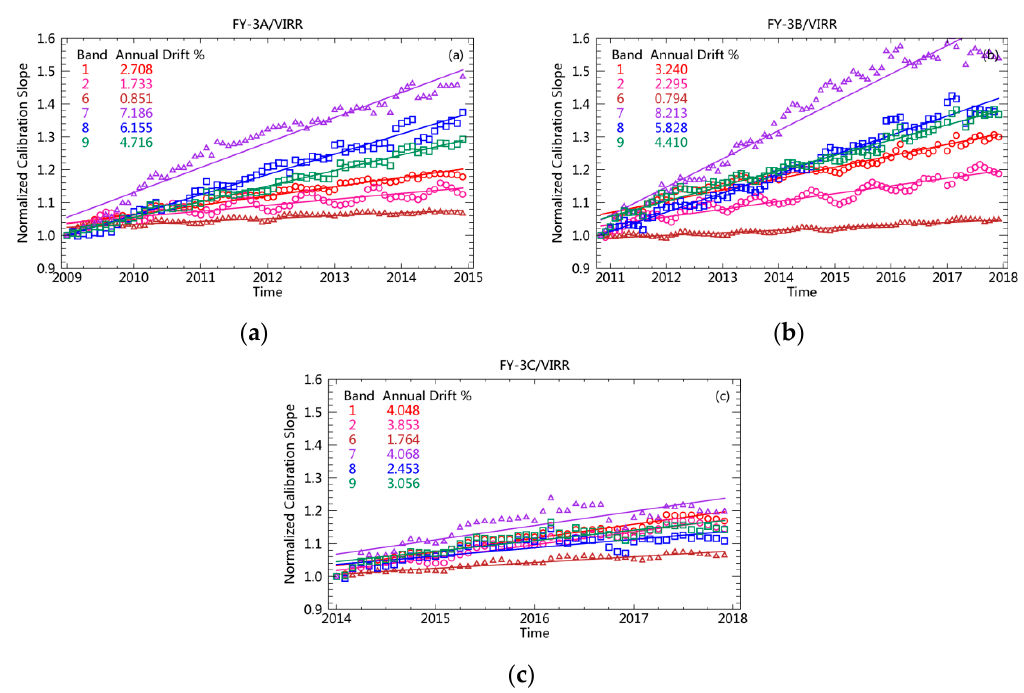
Figure 7. Trends in the VIRR normalized calibration slopes for ( a ) FY-3A, ( b ) FY-3B, and ( c ) FY-3C.